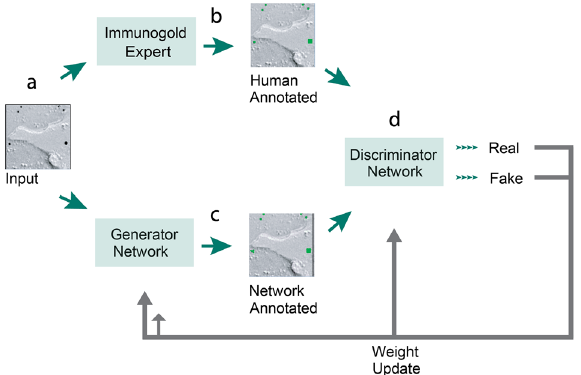
Figure 1. Network Structure of Gold Digger. ( a ) A Cropped FRIL image used for input ( b ) Ground truth image annotated by human experts ( c ) Network-generated image with annotations d. Discriminator network to discern between real and fake